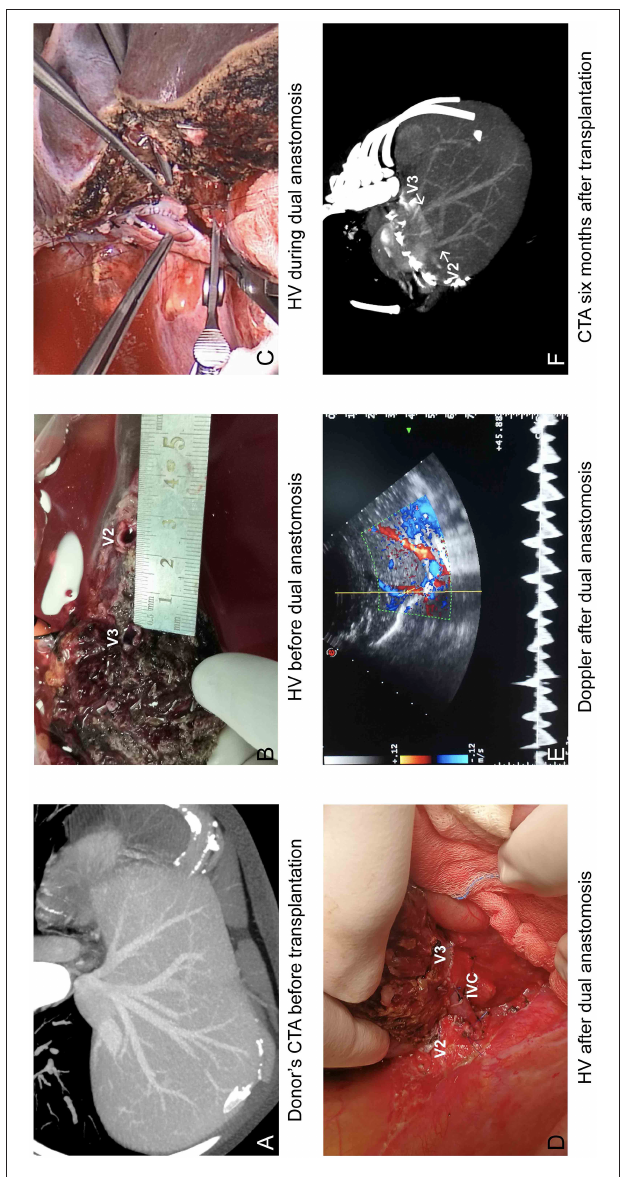
FIGURE 3 | Operational results of modified dual hepatic vein anastomosis. (A) Donor’s CTA before transplantation and (B) during transplantation showed two separated orifices in cut surface; (C) V2 was anastomosed to the common trunk of MHV and LHV, and V3 was anastomosed to longitudinal incision orifice in IVC. (D) HV after dual anastomosis. (E) Venous outflow was satisfactory on Doppler. (F) CTA at 6 months after liver